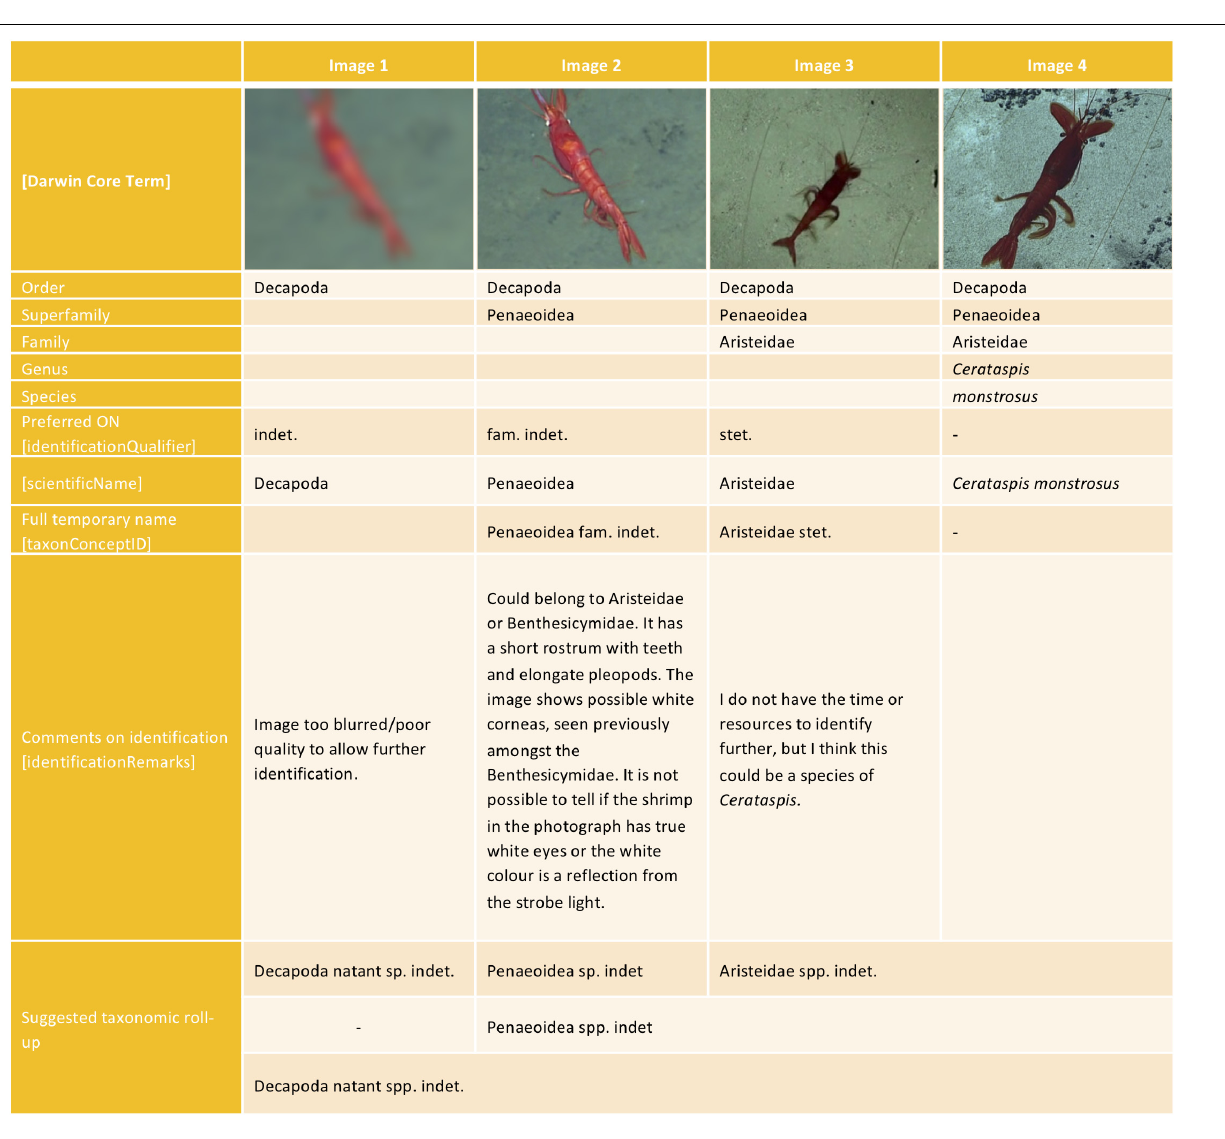
FIGURE 5 | An example of the different levels of certainty of an identification as applied to different images of the same possible taxon, along with recommended ON signs for each. Image 1 and 2 are from Arnés-Urgellés et al. (2020), Image 3 is reproduced with permission from the National Geographic Society’s Exploration Technology Lab, and Image 4 is from NOAA Offce of Ocean Exploration and Research Benthic Deepwater Animal Identification Guide